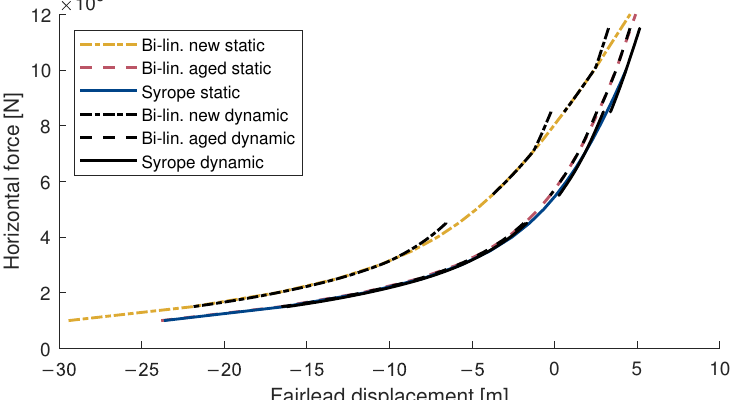
Figure 9. Force–displacementrelationship for a single mooring line using, with dynamic relationships given for loading about mean horizontal forces of 0.3, 0.7 and 1 MN. Fairlead displacement = 0 refers to the installed position of the